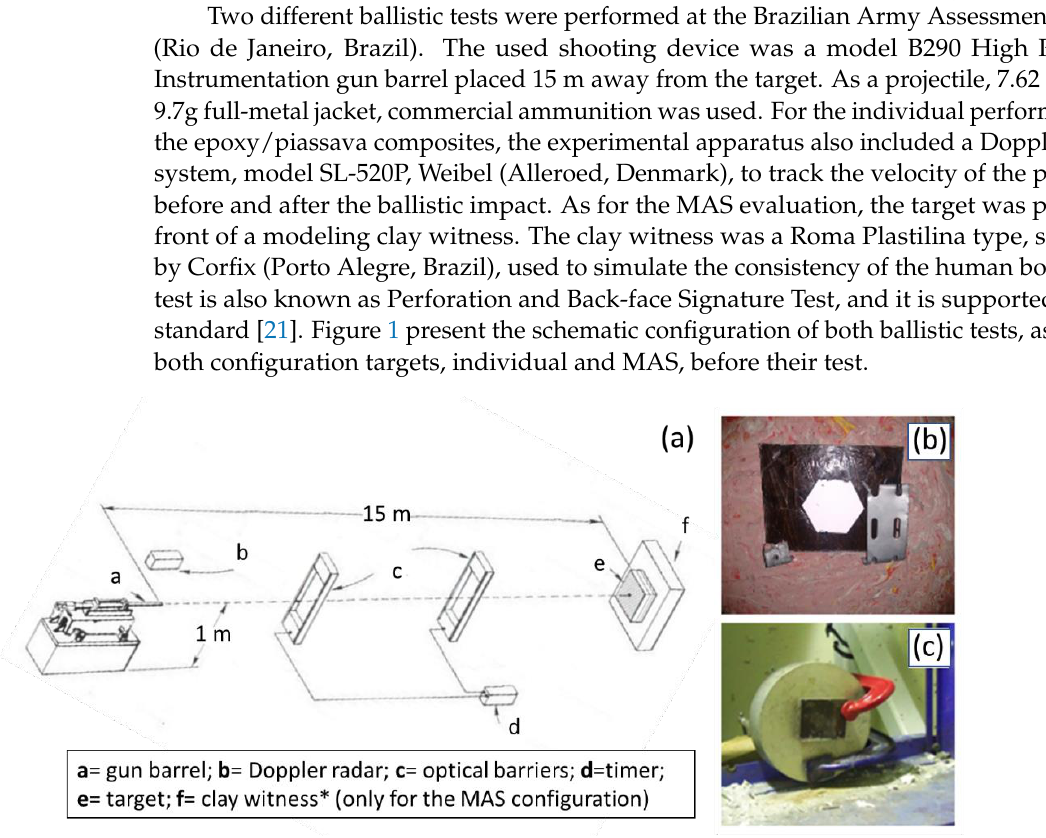
Figure 1. Ballistic test ( a ) schematic illustration; ( b ) MAS target placement, and ( c ) individual performance target placement.